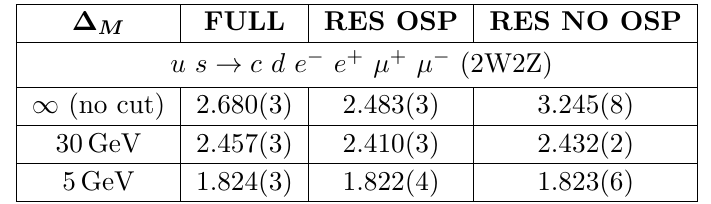
Table 5 . Cross sections ( ab ) for u s All diagrams are taken into account for the full calculation (FULL), while only double resonant diagrams contribute to the two rightmost columns, with (RES OSP) and without (RES NO OSP) projection. Selection cuts are: p j 300 GeV, M > 40 GeV. ‘ + ‘ (cid:0)